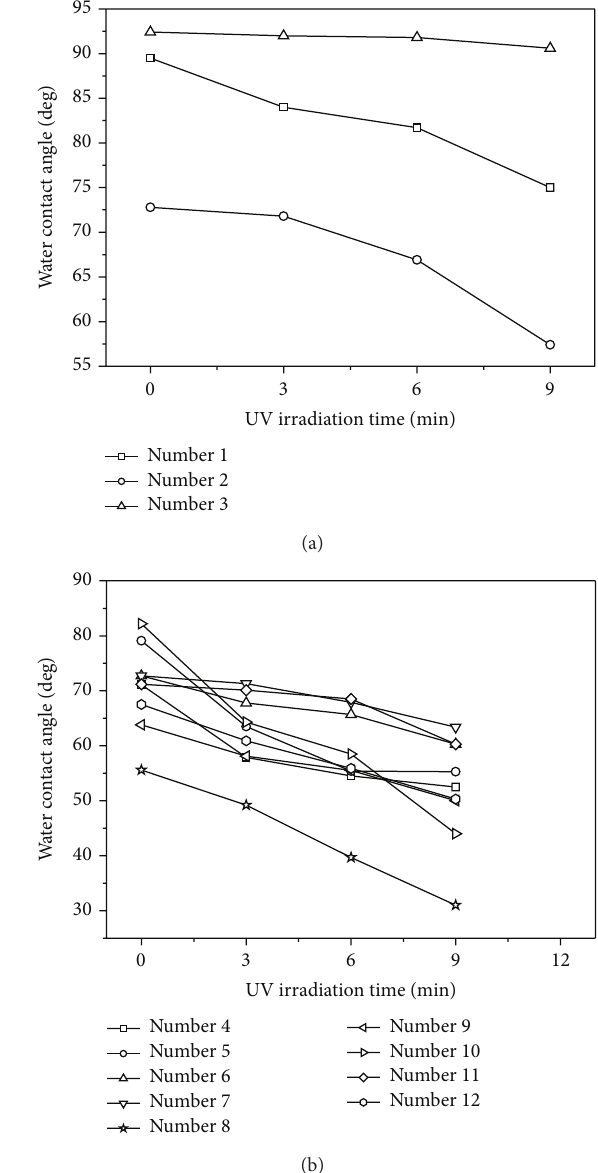
Figure4:ThechangeinthewatercontactangleafterUVirradiation: (a) without nitrogen addition and (b) with nitrogen